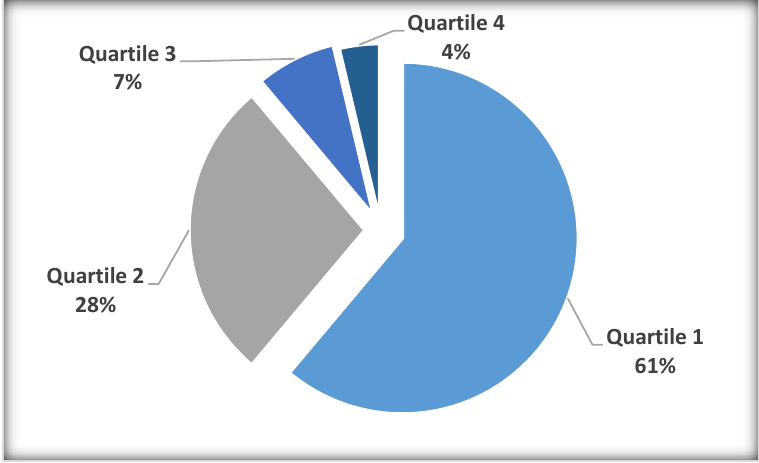
Fig. 5. Percentage distribution of HFS articles according to journals